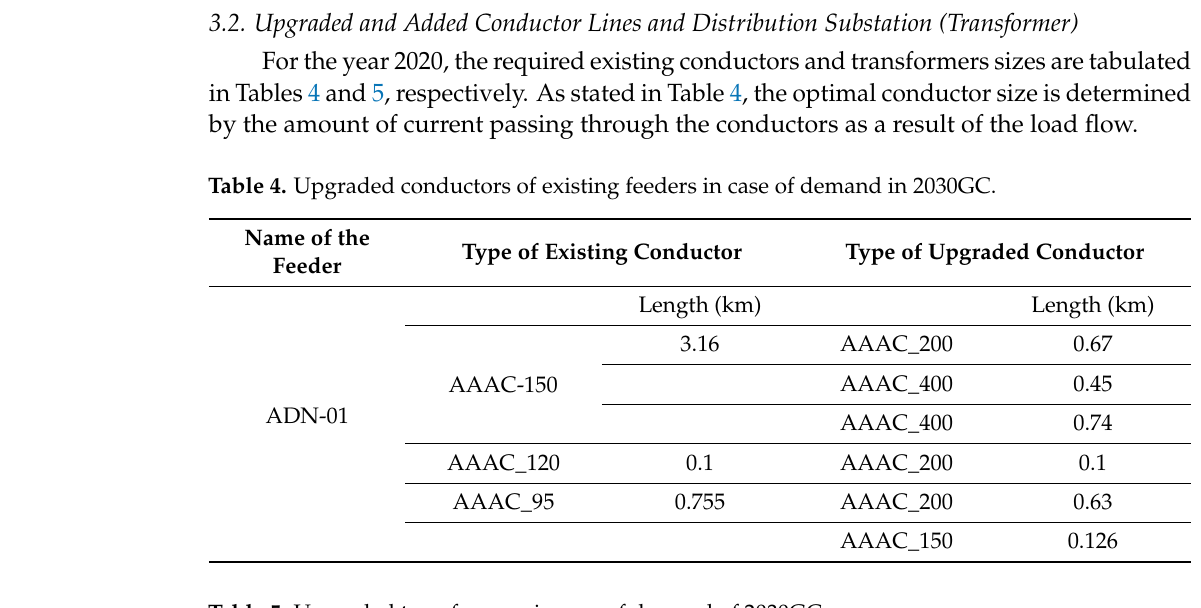
Table 5. Upgraded transformers in case of demand of 2030GC.